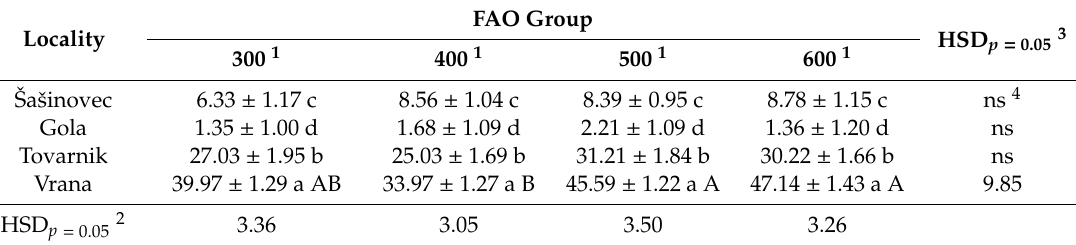
Table 5. The average percent of plants ( ± SD) infested by European corn borer larvae established at four di ff erent locations and in four di ff erent regions in Croatia in 2018 and the results of the statistical analysis.